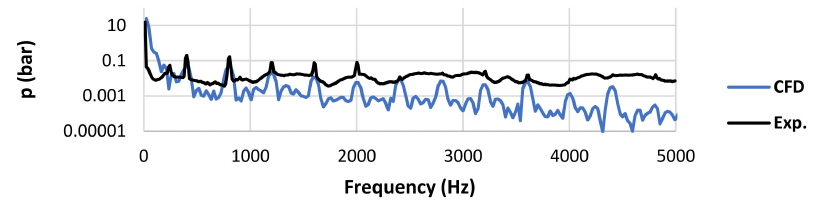
Figure 21. Delivery port pressure ripple FFT analysis obtained from the CFD simulations and the experiment for the BVP at p 2 = 22.5 bar pressure load, 20 ◦ C oil temperature and 2000